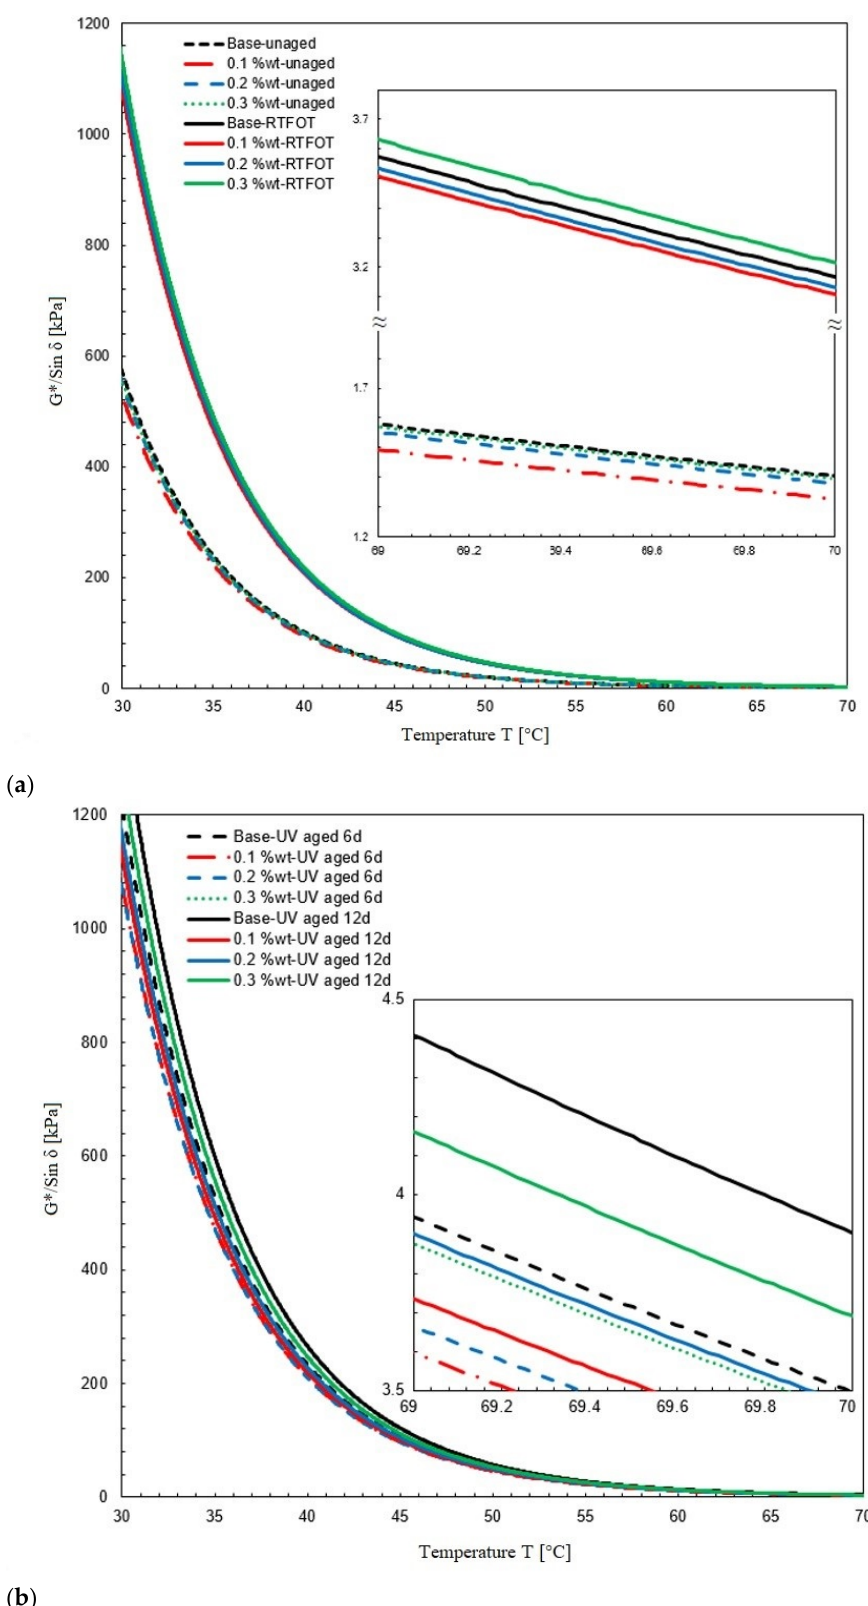
Figure 8. Resistance to the permanent deformation of bitumen samples after ( a ) short-term aging, and ( b ) UV aging.